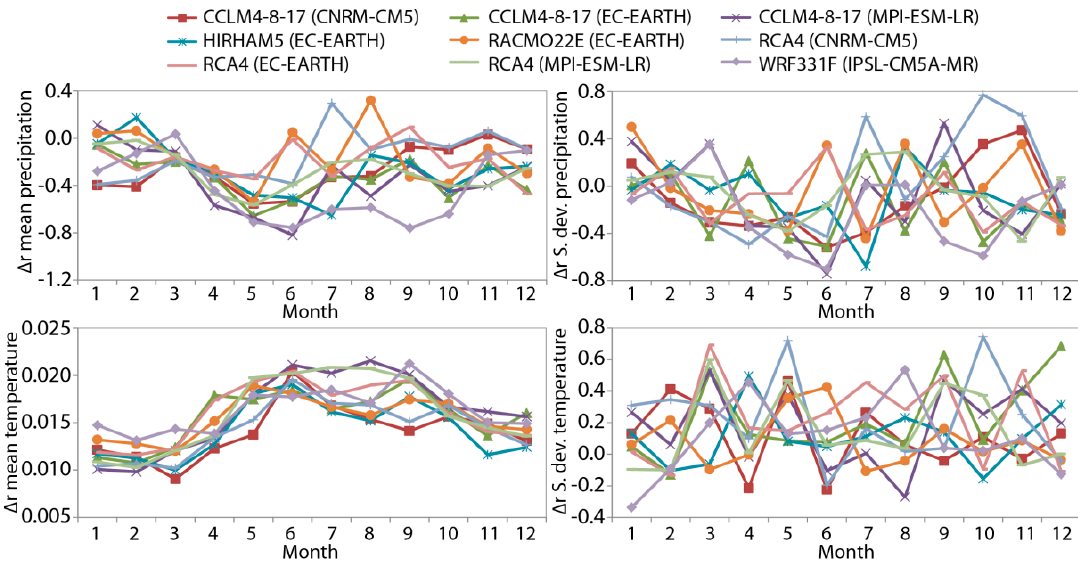
Figure 6. Dimensionless relative monthly change in mean and standard deviation of the future P and T series (2071–2100) with respect to the control series (1971–2000)—lumped approaches. Relative changes calculated as (F − C)/C where F stands for future model projections and C control model simulations.